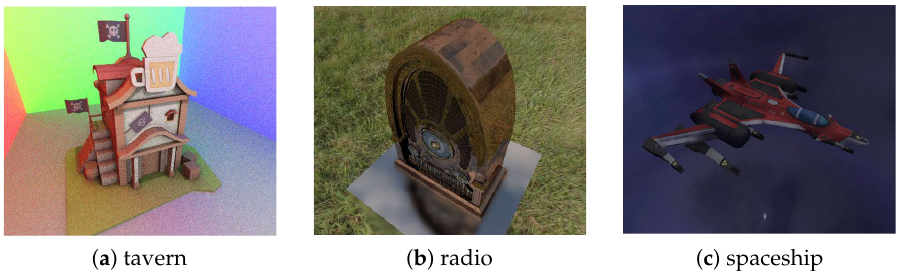
Figure 12. Three different scenes for test cases.